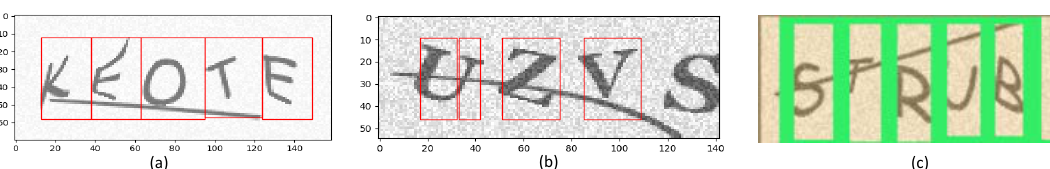
Figure 3. Examples of CAPTCHA Processing. ( a ) Modified Claptcha module provides characters location within image. ( b ) Bad segmentation attempt of the function. ( c ) Example of TOD